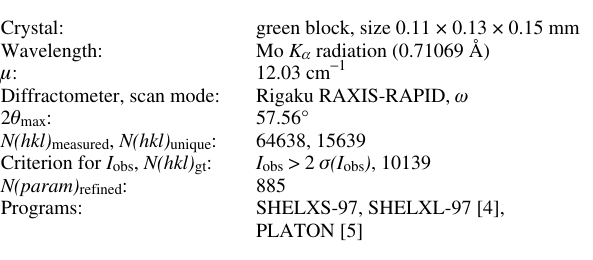
Table 1. Data collection and